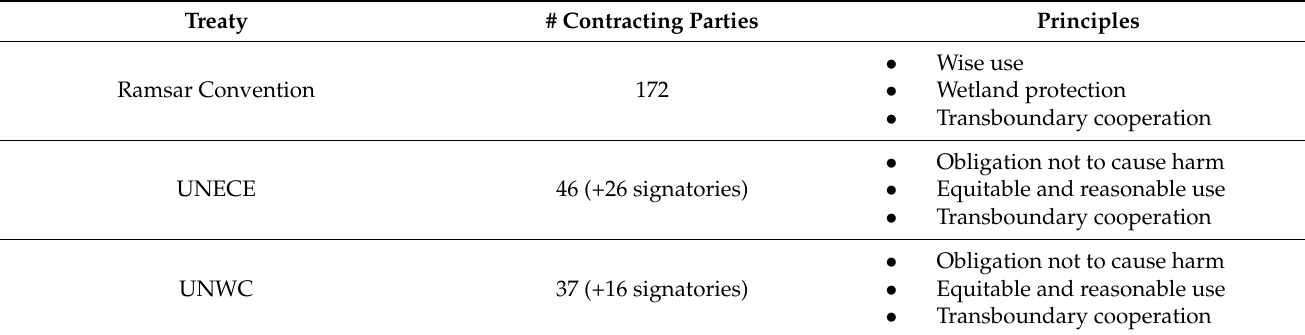
Table 1. Number of contracting parties to the Ramsar Convention, the 1992 Helsinki Convention on the Protection and Use of Transboundary Watercourses and International Lakes (UNECE), and the 1997 United Nations Convention on the Law of Non-Navigational Uses of International Watercourses (UNWC). Data sourced from the United Nations Treaty Collection (https://treaties.un.org/ accessed on 9 May